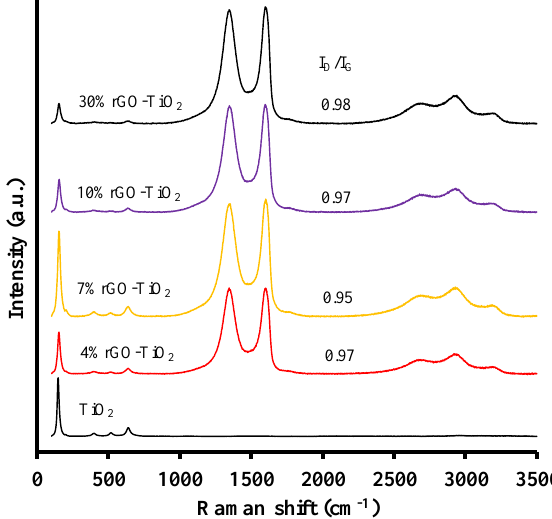
Figure 7. Raman spectra of TiO 2 and xrGO-TiO 2 composites. Table 5. Parameters obtained from Raman spectra for TiO 2 and xrGO-TiO 2 composites.